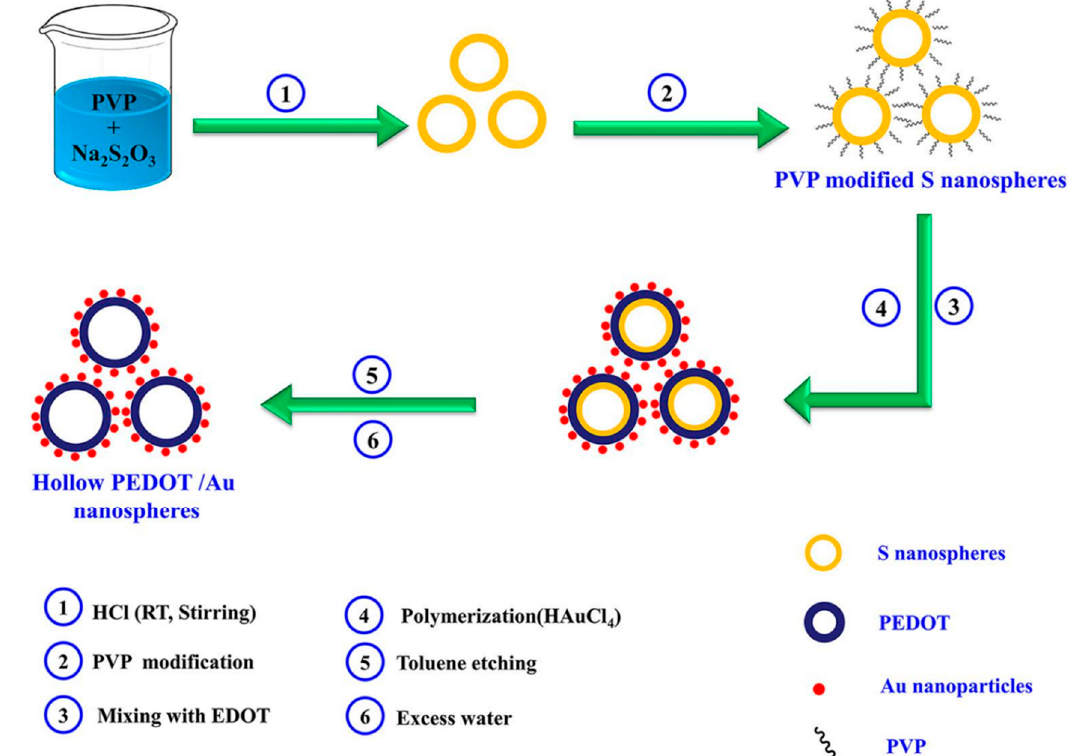
Figure 6. Schematic representation of the fabrication process of PEDOT/Au composites. Reproduced with permission from [114]. Copyright 2017 Elsevier B.V.